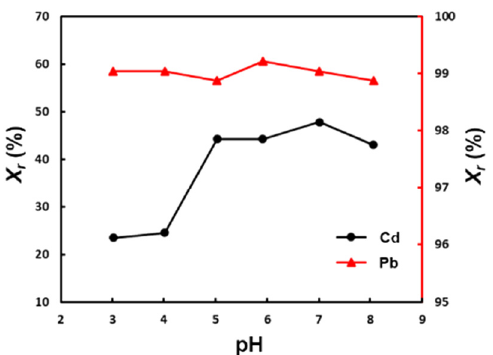
Figure 6: Adsorption e ffi ciency of Cd 2 + or Pb 2 + onto pollen@FePO 4 microspheres as a function of pH. Sample: 50 mL, 40 mg · L − 1 Cd 2 + or